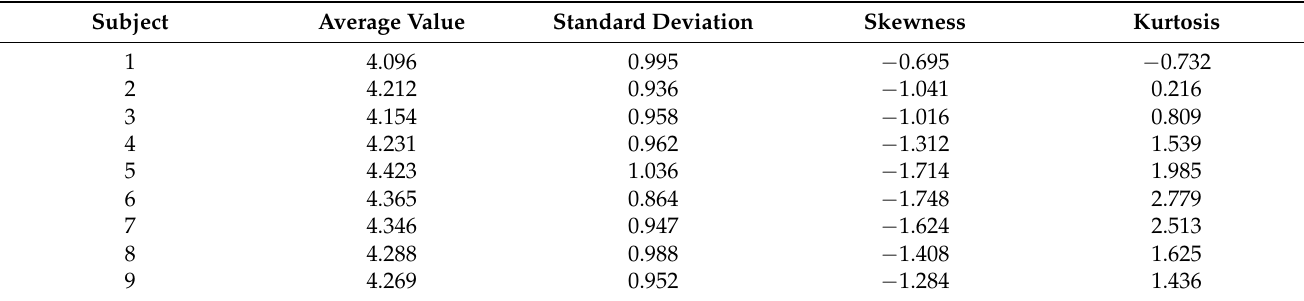
Table 16. Normality test of user’s subjective preference data with different styles of keys.